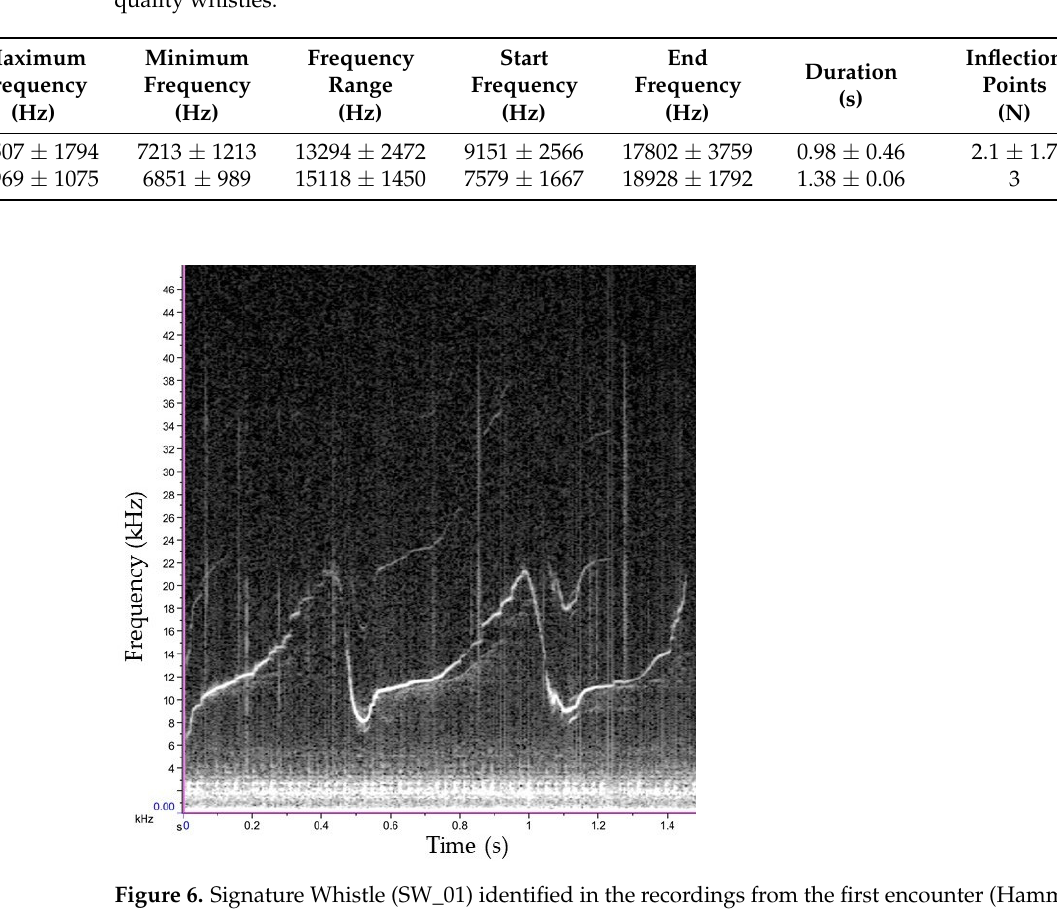
Figure 7. Carcass of the calf with the fetal folds still visible and inflated belly.